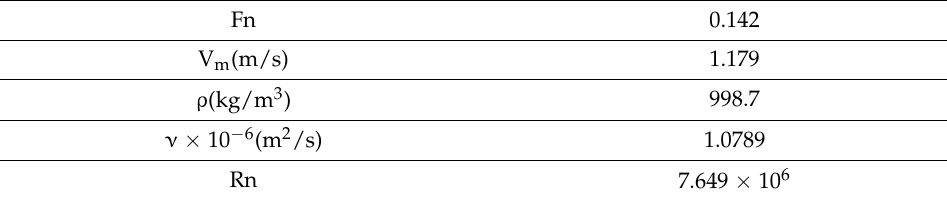
Figure 4. Surface grid of JBC around the stern.